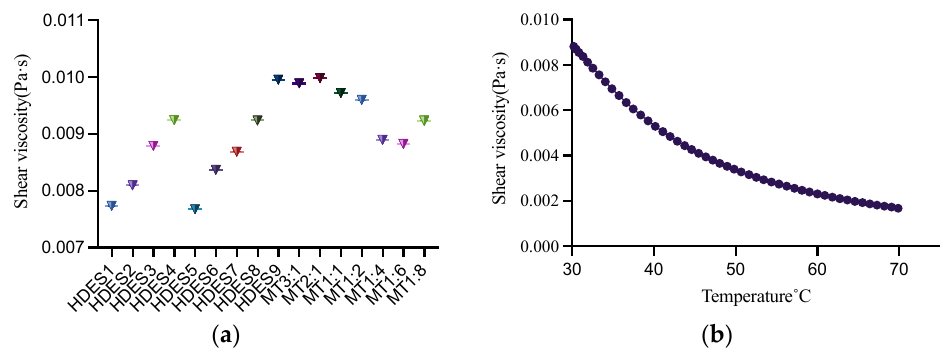
Figure 2. The viscosity of different HDESs at 30 °C ( a ) and the viscosity of MT1:6 at 30~70 °C ( b ) .